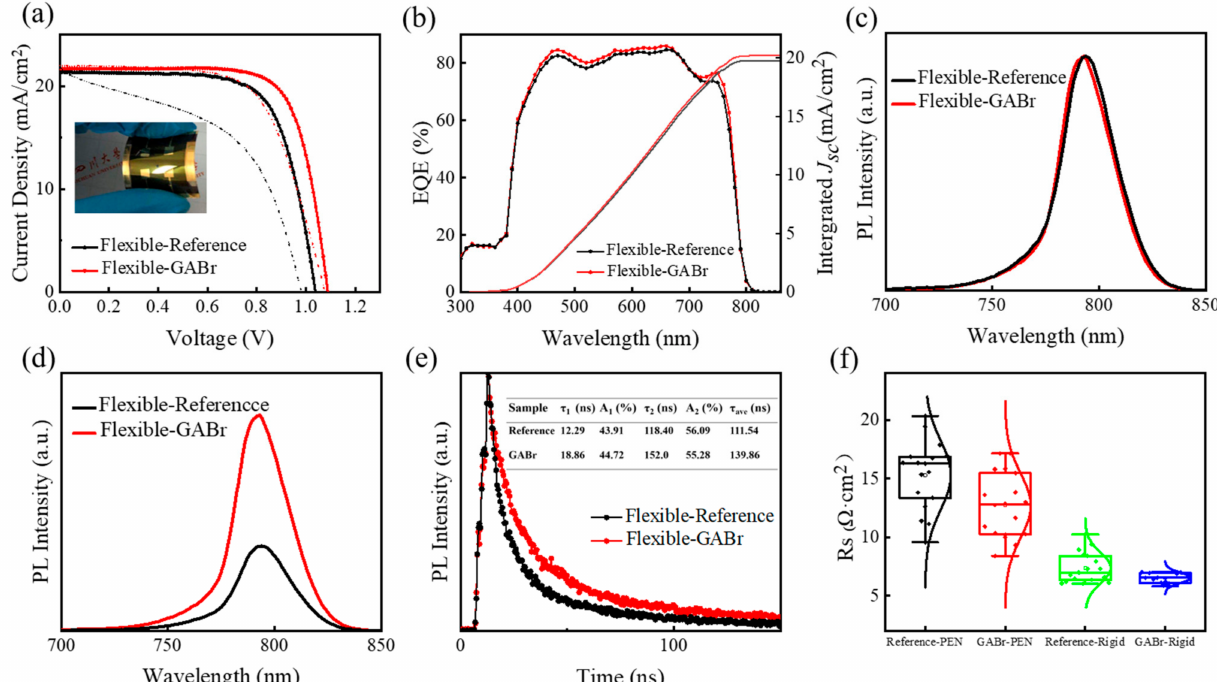
Figure 9. ( a ) The J-V curves and ( b ) EQE spectra of the champion cells based on MAPbI 3 and GABr-treated flexible device. ( c ) The normalized PL spectra of MAPbI 3 and GABr-treated film. ( d ) PL and ( e ) TRPL results of MAPbI 3 and GABr-treated films, and the inset table is the corresponding parameters of the fitting results. ( f ) The statistical results of R s of pristine devices and GABr-based devices deposited on two